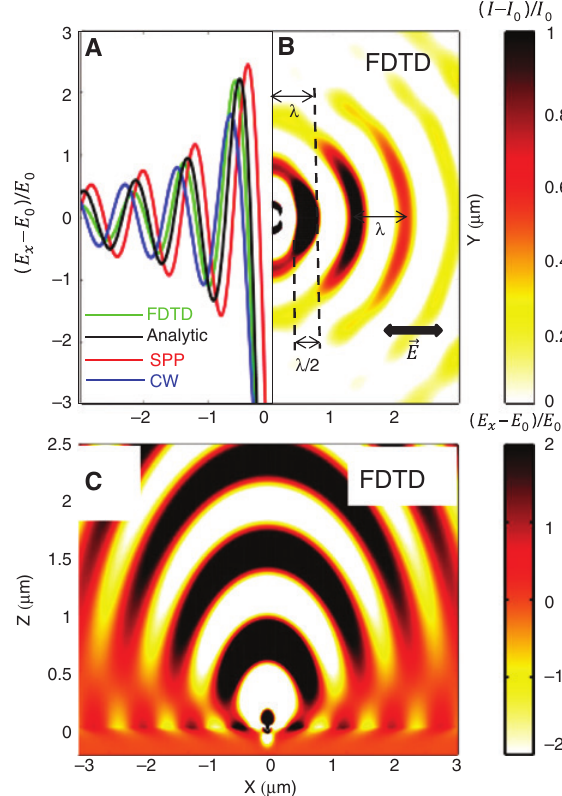
Figure 2: Electromagnetic response of a single hemispherical nanohole on a metal surface. (A) Comparison between FDTD (green) and analytical (black) solution for a single subwavelength hole along the X -direction ( y = 0, z = 0). The scattered field E is decomposed on the surface plasmon wave x (SPP, red) and the quasi-cylindrical wave (CW, blue) contributions. (B) The intensity distribution near a hemispherical nanohole with R = 50 nm in the transverse plane of a stainless steel surface. (C) The electric field E in the propagation plane calculated by x